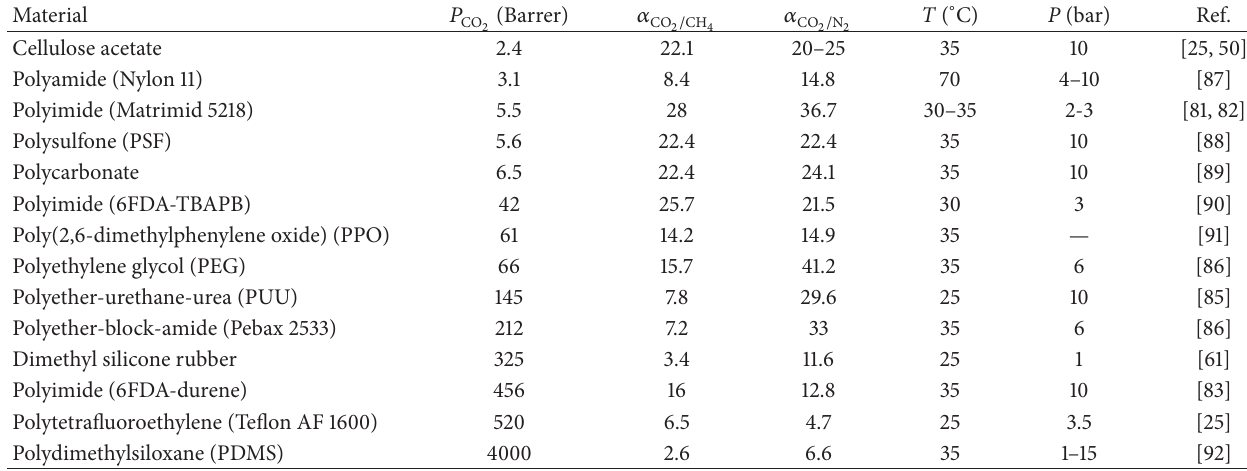
Table 4: Permeability and selectivity of different polymers for carbon dioxide